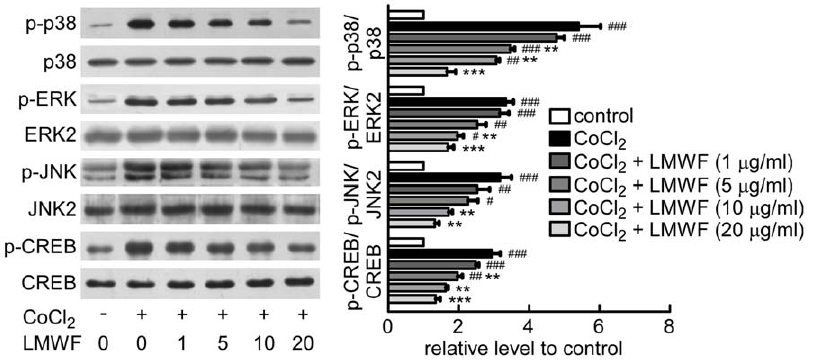
Figure 9. LMWF inhibited MAPK signaling pathways in HK2 cells exposed to CoCl 2 . Expression and phosphorylation levels of ERK, p38, JNK, CREB in HK2 cells treated with 600 m M CoCl 2 for 30 min were detected by Western blot analysis. Representative blottings ( left ) and relative ratios of protein levels ( right ) are shown. Each bar represents the mean 6 SEM. n=3; # P , 0.05, ## P , 0.01, ### P , 0.001 vs. control, ** P , 0.01, *** P , 0.001 vs. CoCl 2 treated group.